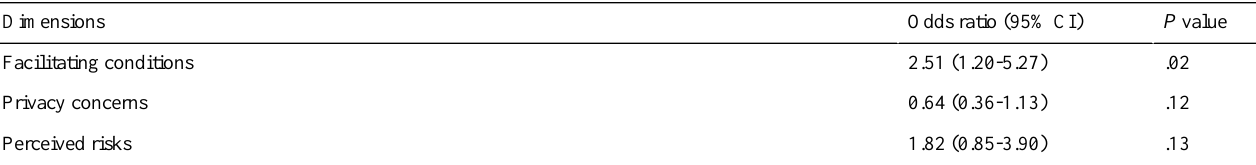
Table 7. Multivariate logistic regression model with 3 selected features.